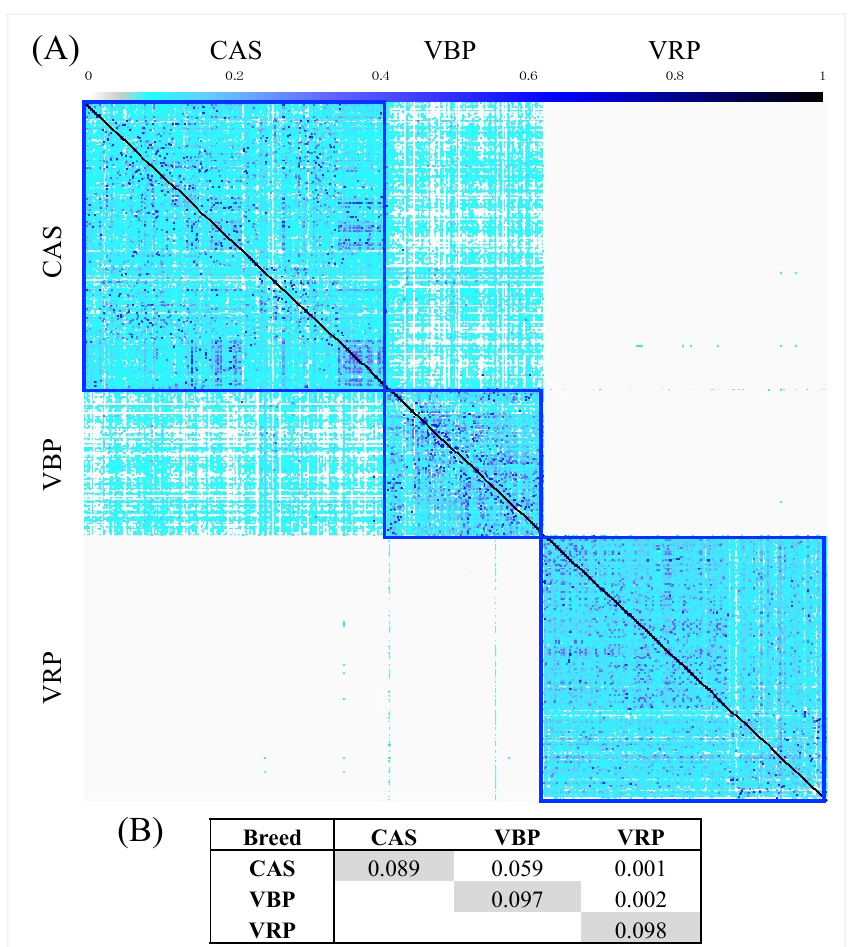
Figure 5. ( A ) Probability of alleles identical by descent (IBD) overview diagram calculated for all individuals. Blue squares represent the probability of IBD within each of the three populations; ( B ) average genomic relationships within (in diagonal—grey) and between populations (out of diagonal).